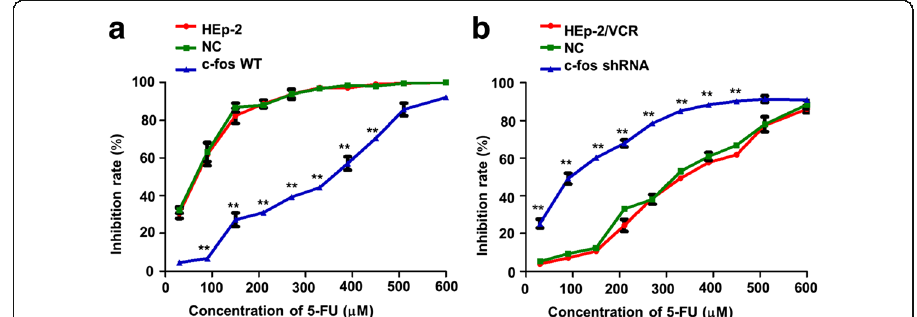
Fig. 4 MTT assayof the changes in cell sensitivity to chemotherapeutic drugs after c-fos knockdown in HEp- 2/VCR cells or c-fos overexpression in HEp-2 cells. All the groups of monoclonal cells were treated with various concentrations of 5-FU for 48 h. Concentration – effect curves showing the differences in the 5-FU IC 50 forvarious groups of cells. a The IC 50 for 5-FU in the c-fos WT group was 268.5 ± 6.51 μ mol/l, which was 4.86 times that of the NC group (55.2 ± 2.31 μ mol/l; p < 0.01). b The IC 50 of 5-FU had decreased by 75% in the c-fos shRNA group (80.2 ± 2.3 μ mol/l) compared to the value for the NC group (309.2 ± 4.21 μ mol/l; p < 0.01). Data are shown as the means ±SD. **p < 0.01